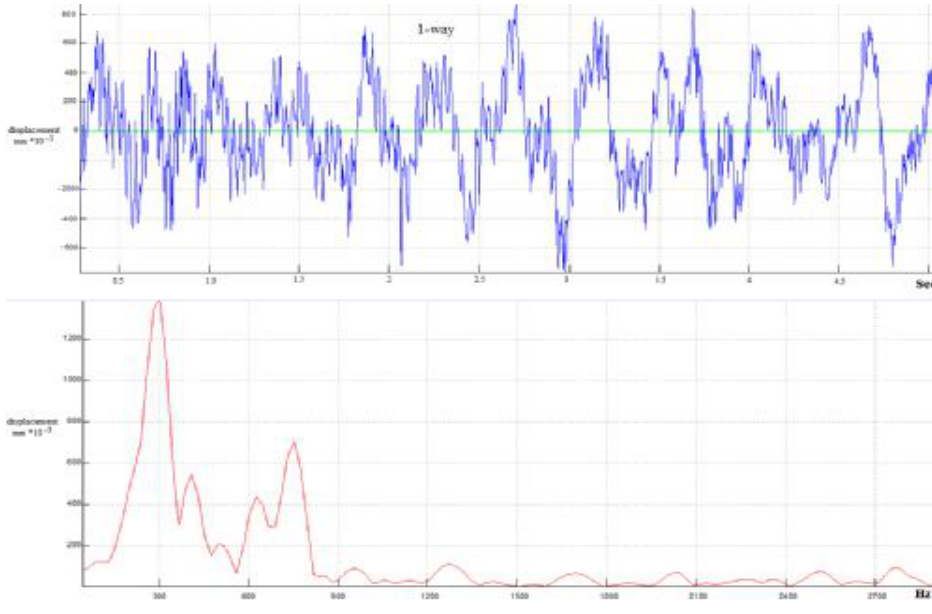
Fig. 8. Displacement of globe valve obtained from numerical solution